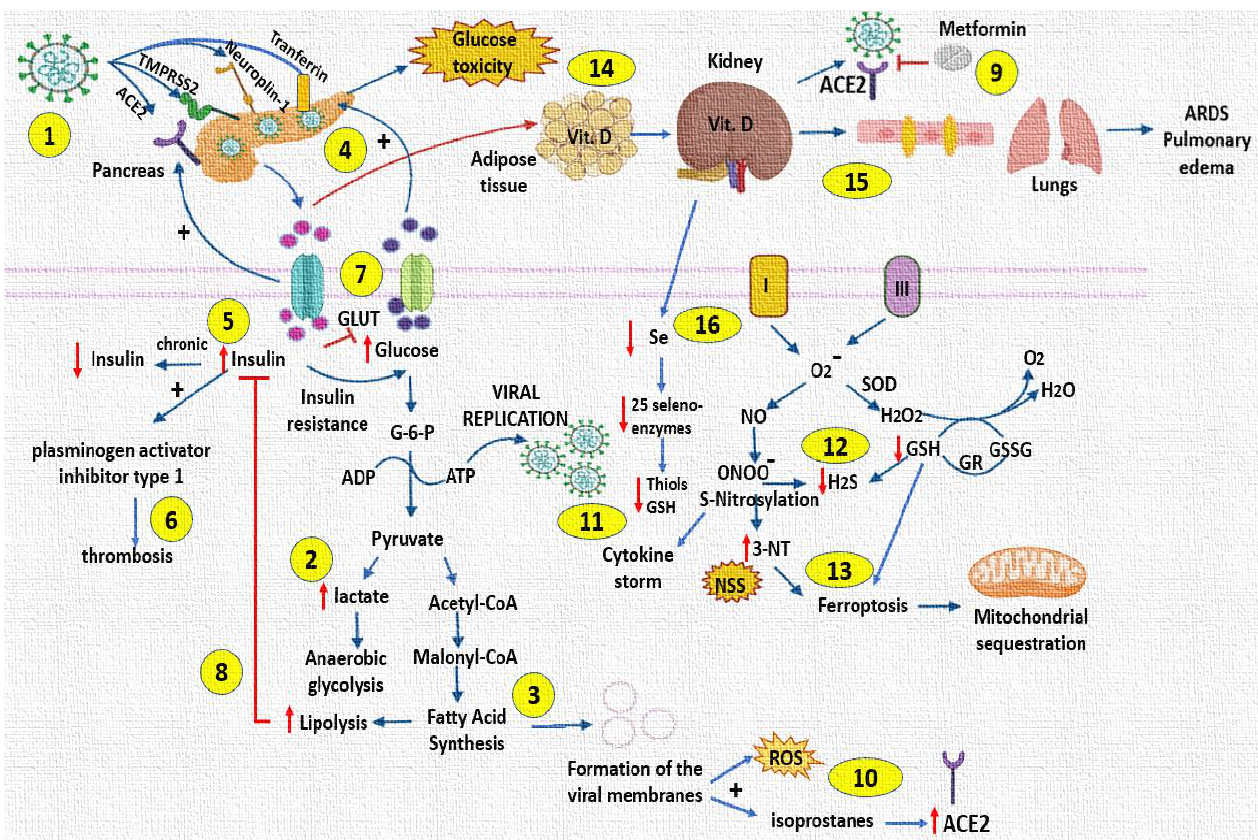
Figure 6. Alteration of the glucose – insulin axis by SARS-CoV-2, and the impact on some antioxidant markers in patients. ( 1 ) Entry of COVID-19 through various receptors in the pancreas. ( 2 ) COVID-19 increases lactate levels, favoring viral replication. ( 3 ) Increased free fatty acids are used for viral membrane formation. ( 4 ) Increased glucose overstimulates pancreatic β -cells and subsequently impairs their function. ( 5 ) Chronically increased insulin concentrations will lead to depletion of insulin reserves. ( 6 ) Hyperinsulinemia may favor the development of thrombosis. ( 7 ) Hyperglycemia inactivates GLUT 1 but SARS-CoV-2 could increase -3, -4 and -8, transporters. ( 8 ) Increased lipolysis blocks the response to insulin by the liver, adipose tissue and muscles. ( 9 ) Metformin prevents the interaction of the ACE2 receptor and COVID-19. ( 10 ) Increased free fatty acid synthesis favors the generation of 8-isoprostanes, which favor ACE2 receptor overexpression. ( 11 ) ONOO – favors interleukin storm. ( 12 ) ONOO – decreases H 2 S concentration. ( 13 ) Nitrosative stress and depletion of GSH concentrations is associated with ferroptosis and mitochondrial sequestration by the virus. ( 14 ) Under conditions of hyperinsulinemia, Vitamin D is sequestered in adipose tissue and inactivated in the kidney, which favors the interaction of virus S protein with the ACE2 receptor. ( 15 ) Vitamin D deficiency generates ruptures in the gap junctions of lung endothelial cells. (16) Vitamin D deficiency is associated with Se deficiency which affects selenoenzymes. Abbreviations: ARDS = acute respiratory distress syndrome, H 2 O 2 = hydrogen peroxide, H 2 S = sulfhydryl acid, G-6-P = glucose 6 phosphate, GR = glutathione reductase, GSH = glutathione, GSSG = oxidized glutathione, NO = nitric oxide, NSS = nitrosative stress, O 2 – = superoxide, ONOO – = peroxynitrite, ROS = reactive oxygen species, SOD = Superoxide dismutase.